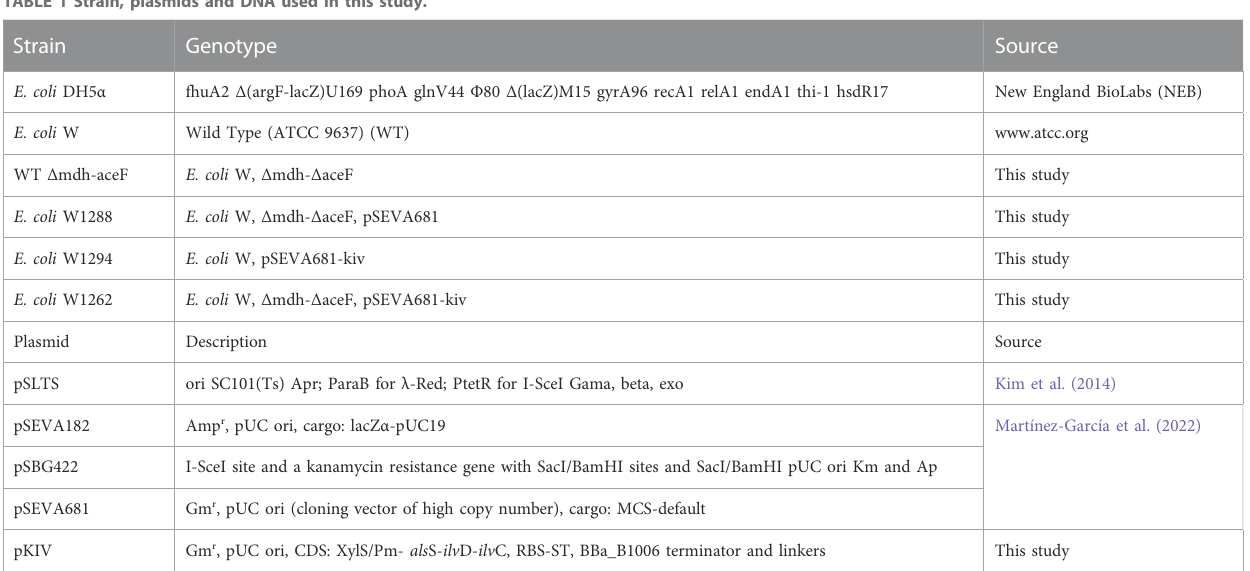
TABLE 1 Strain, plasmids and DNA used in this